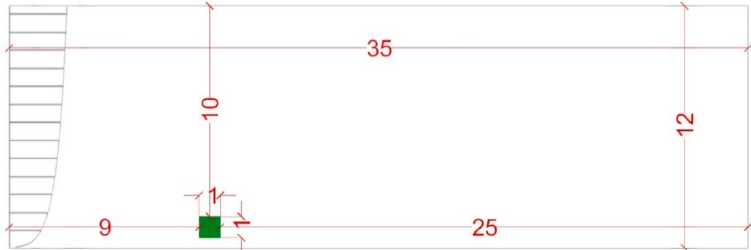
Figure A2. 2D Simulation domain to validate vegetation model; the green patch represents the implemented tree.